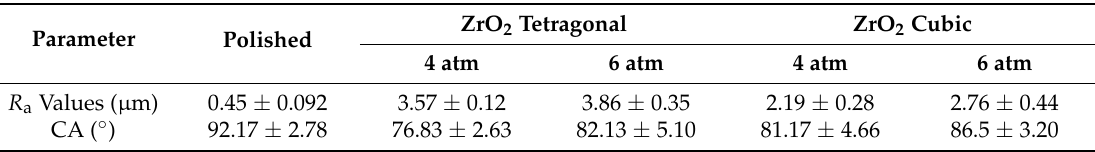
Table 2. R a values ( µ m) and CA ( ◦ ) measurement results after treatment with different particle shape and time.